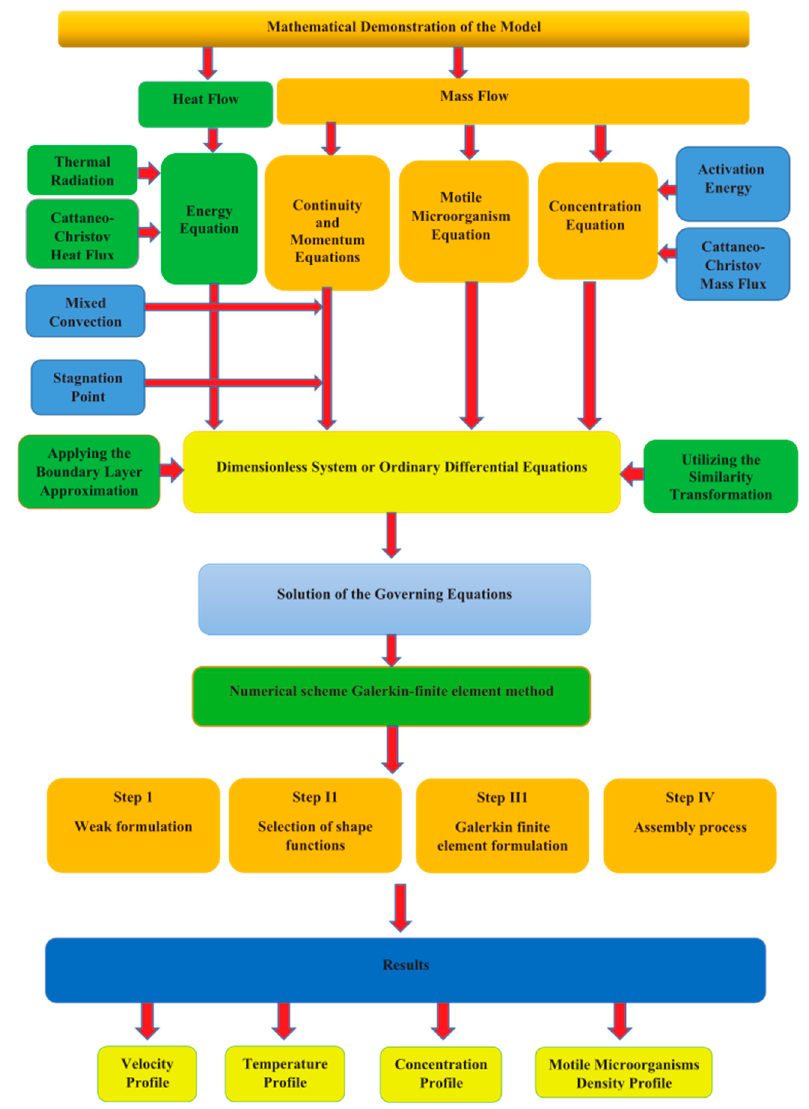
Figure 1. Flow chart of the proposed mathematical model.